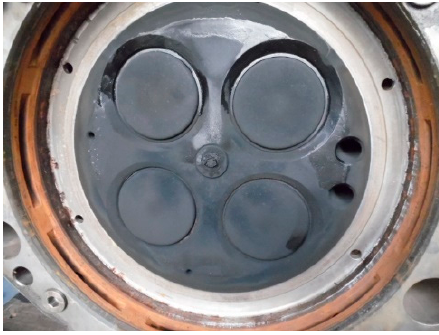
Figure 26. Cylinder head and injector nozzles.